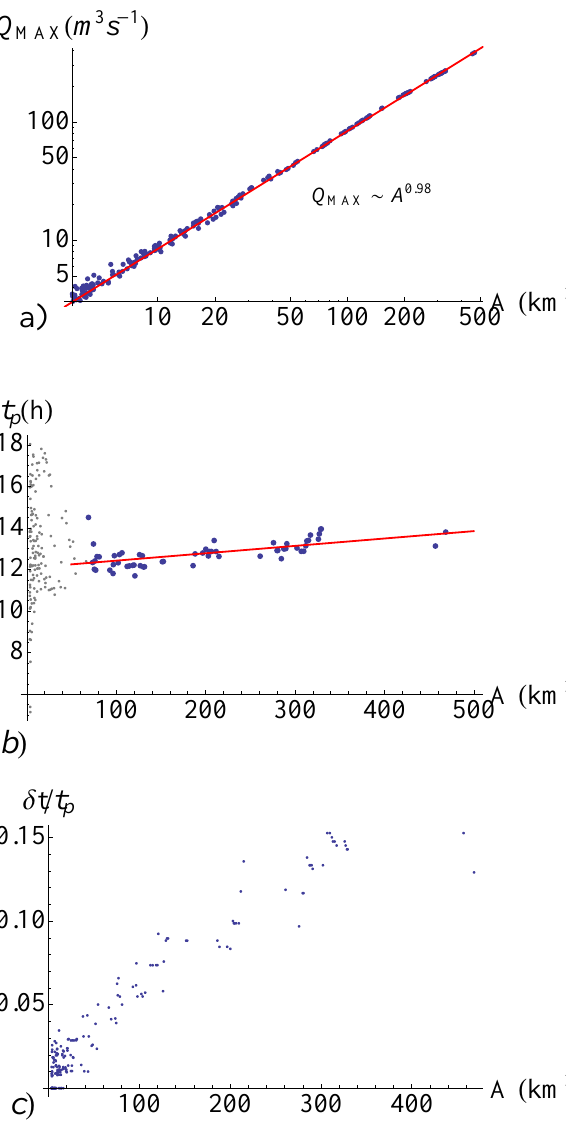
Fig. 5. (a) Plot of the peak discharge Q MAX for all the links within the Avisio basin (Italy) as a function of contributing area. The pa- rameters ( q = 30%, u c = 2ms − 1 , r = u/u h = 100) were obtained from calibration on some real event in a few subcatchments and using IDF curves for a return period t r = 100yr. (b) Critical rain- fall duration, t ∗ p , of links ends inside the Avisio basin (Italy). For smaller contributing areas (indicated in the Figure as grey points) t ∗ p and Q MAX are affected by the variability of the hillslope length. (c) Delay of the time to peak with respect to the rainfall duration as a function of the contributing areas.